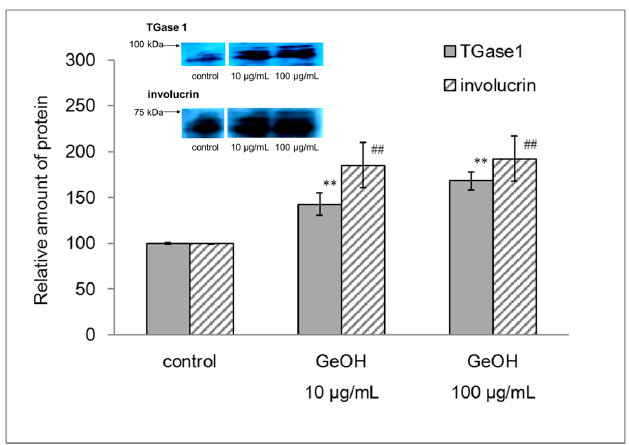
Figure 1. Effects of GeOH on TGase1 and involucrin expression in cultured epidermal keratinocytes. HaCaT cells were cultured for 4 days in medium supplemented with 10 or 100 μ g/mL GeOH, and the protein levels of TGase1 and involucrin were determined by Western blotting when the same amount of proteins was loaded. The results are presented as the mean ± S.D. of three experiments. ** p < 0.01 vs. TGase1 control, ## p < 0.01 vs. involucrin control.